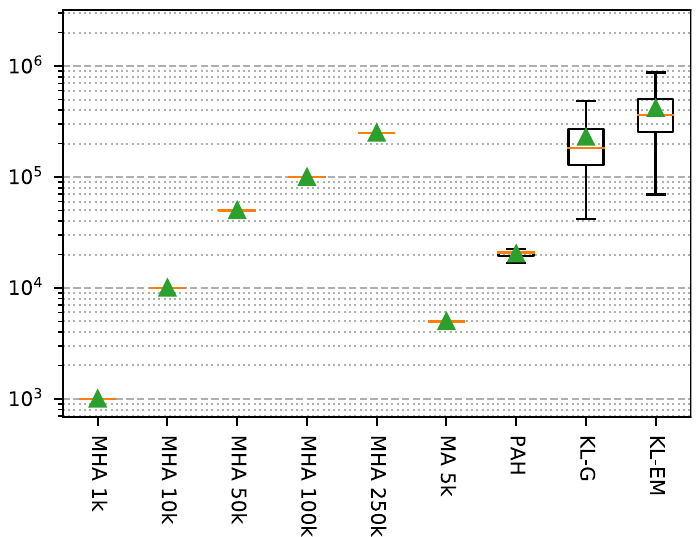
Fig 13. The recorded number of calculated deltas of the studied inference algorithm during all performed runs for Fig 11.